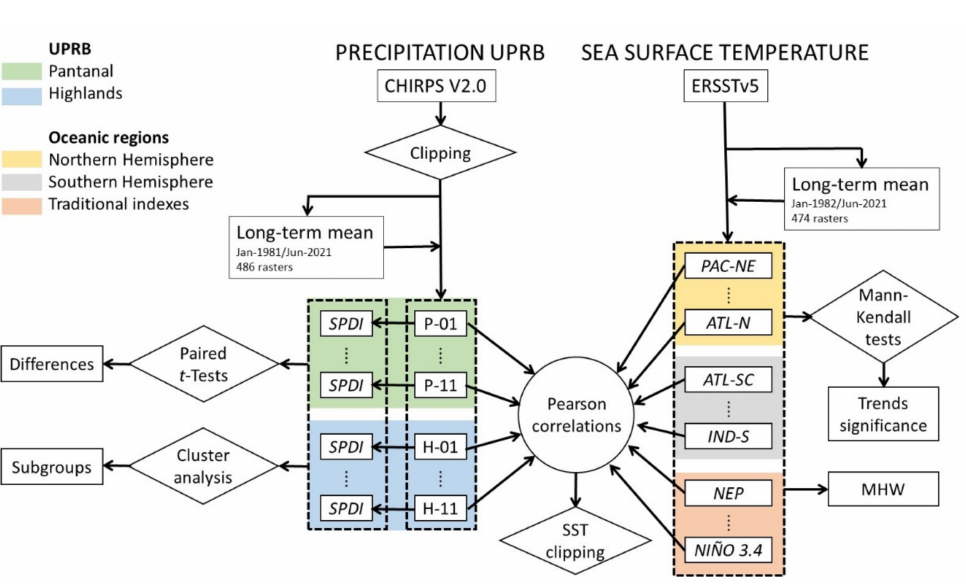
Figure 3. Scheme of the workflow, which was based on the time series from January 2019 until June 2021, except when indicated. Land and oceanic regions were described in Figures 1 and 2,